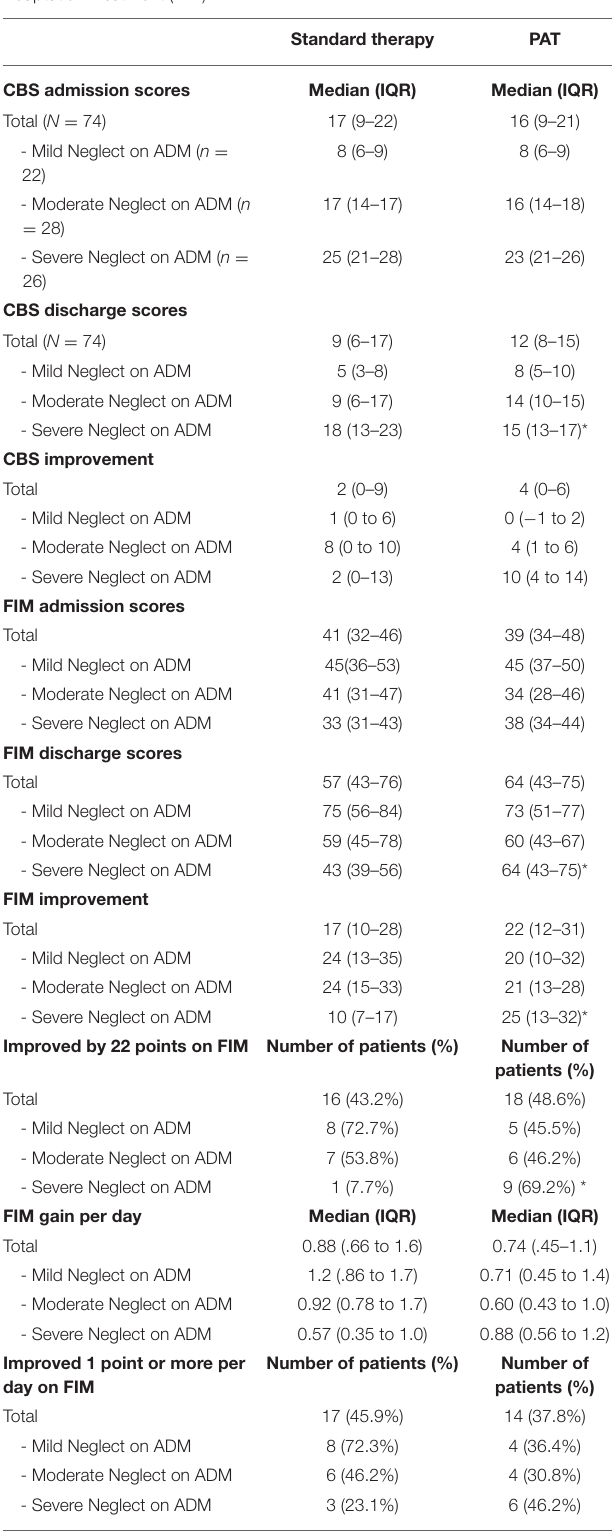
TABLE 3 | Improvement of neglect, functional independence and other outcomes in patients who received standard therapy or standard therapy with Prism Adaptation Treatment